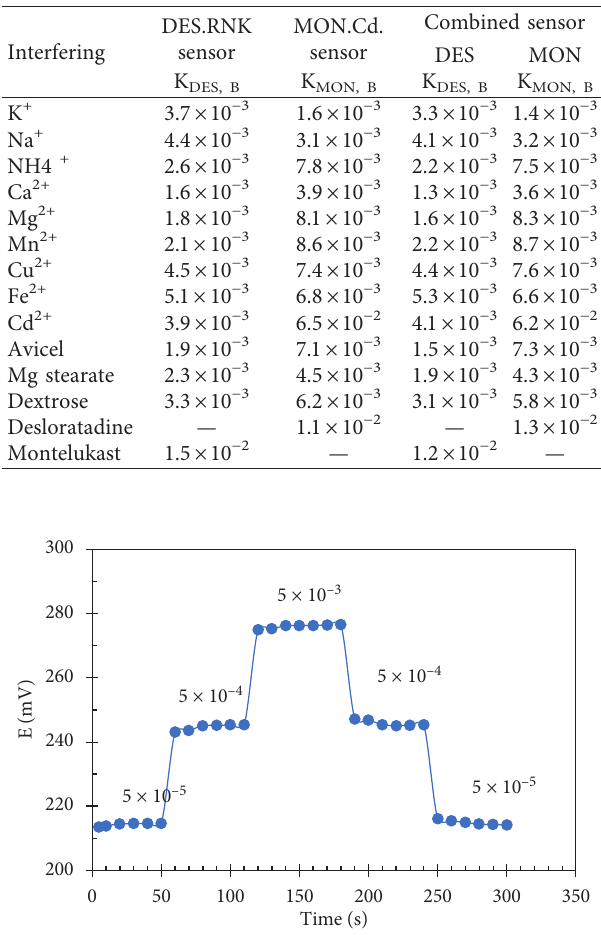
Figure 7: Dynamic response time and reversibility of DES.RNK electrode.